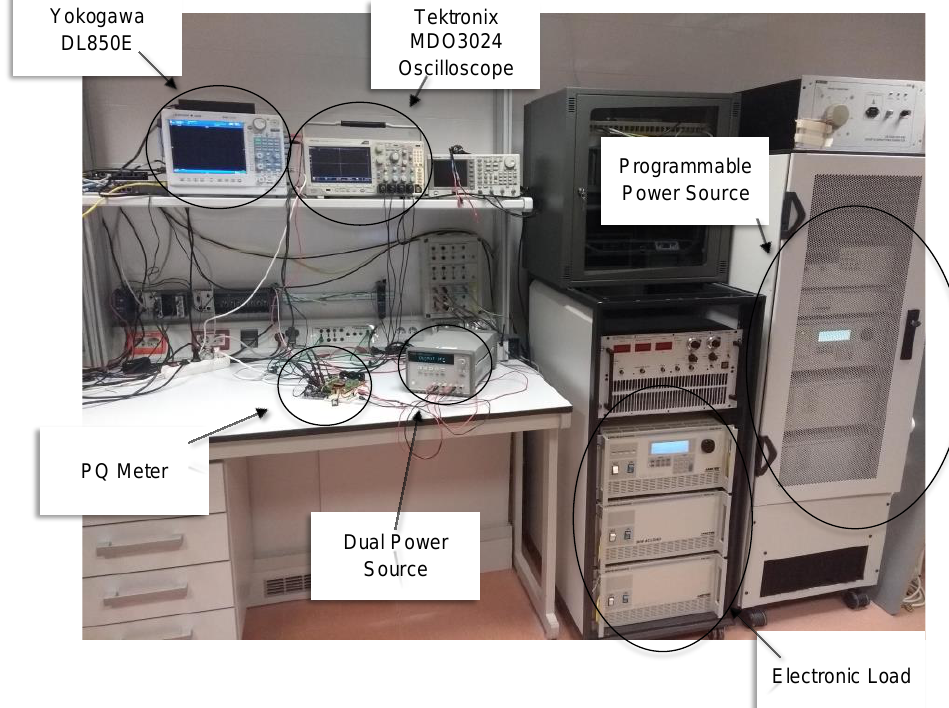
Figure 13. Overview of the laboratory test bench.